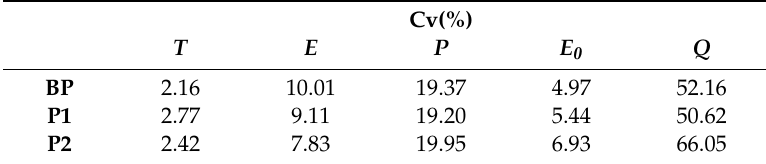
Table 2. The coe ffi cient of variation of temperature, actual evapotranspiration, precipitation, potential evapotranspiration, and runo ff depth.